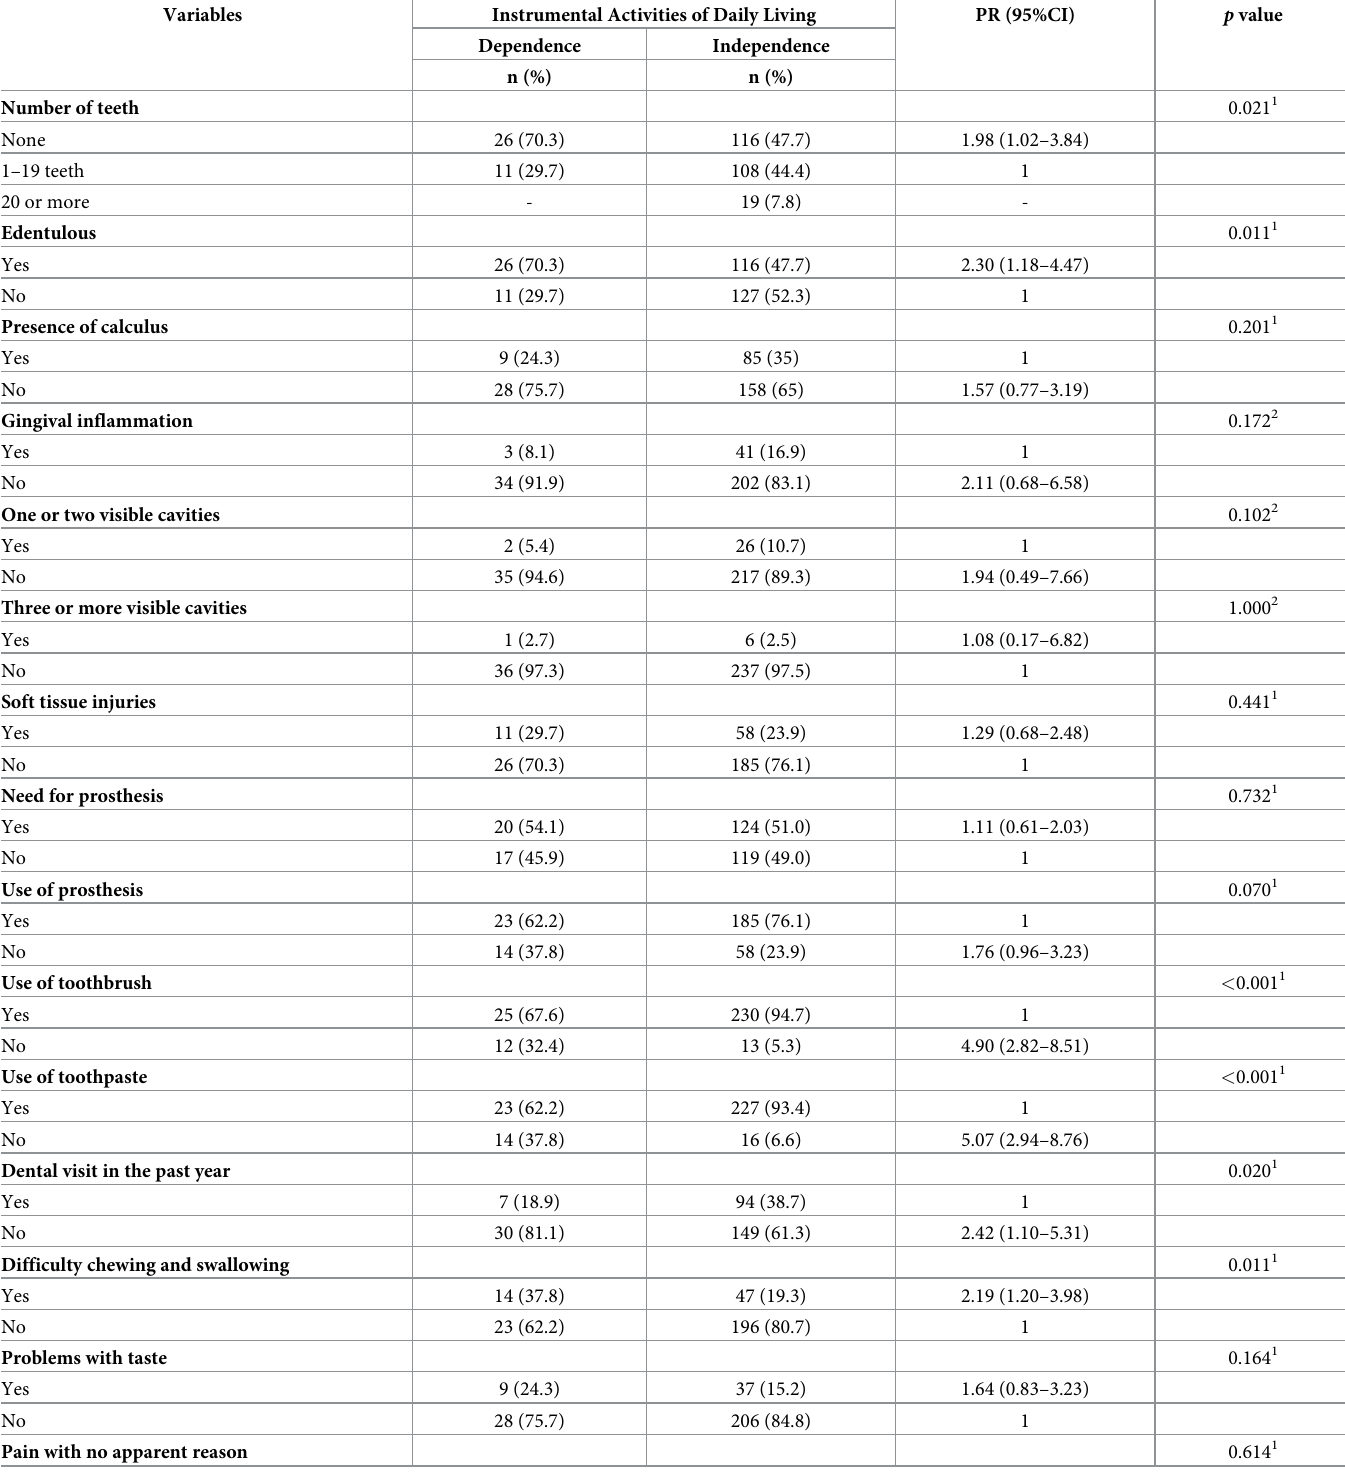
Table 3. Frequency distribution and inferential analysis of older people’s oral health status and oral discomfort variables versus dependence and independence in instrumental activities of daily living